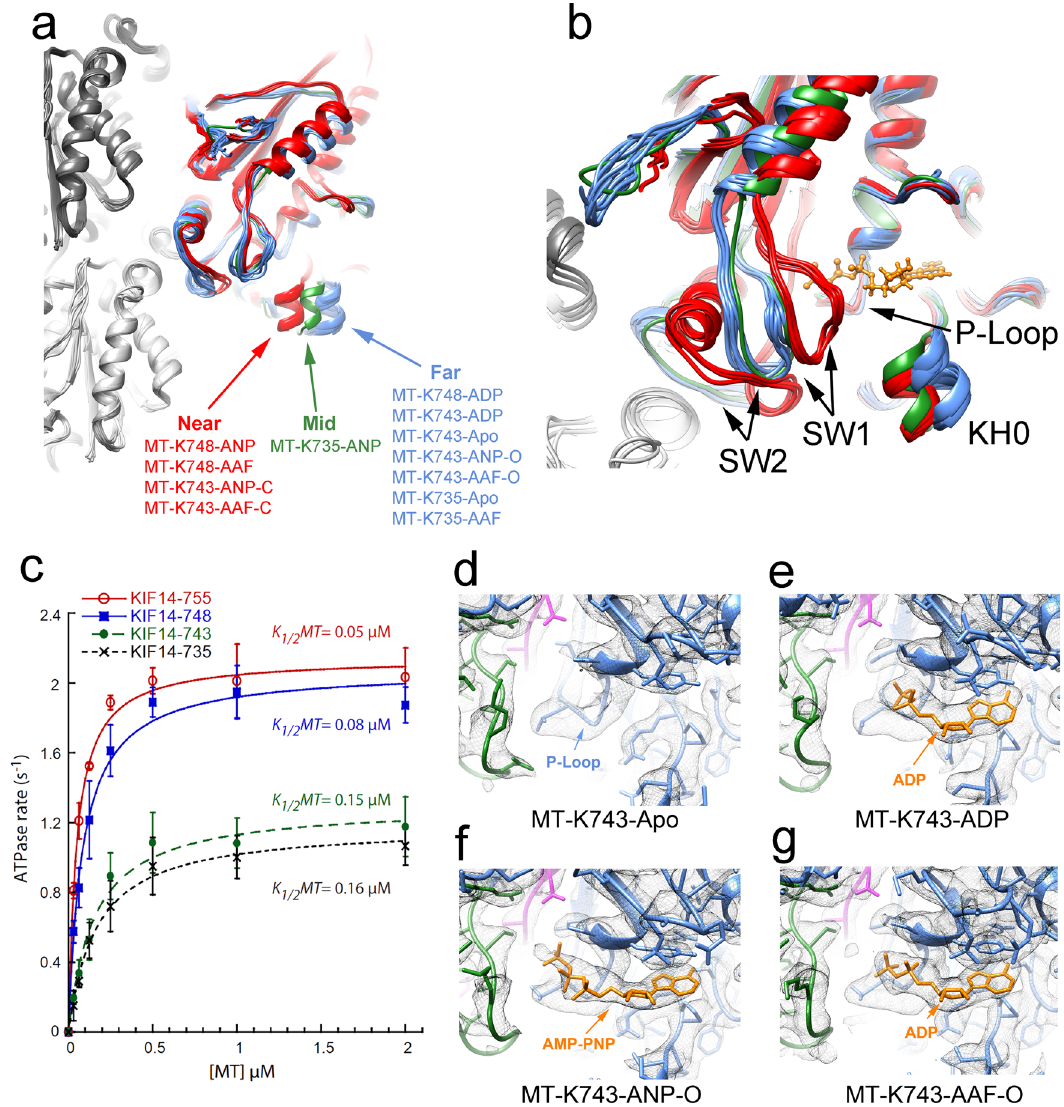
Fig. 5 Neck-linker control of nucleotide-binding pocket closure. a MT-KIF14 atomic models aligned to their corresponding β -tubulin chains. Three distinct locations of KH0, are observed: near, corresponding to the closed con fi guration (red); mid and far corresponding to the open/open* con fi gurations (green and blue). b Nucleotide-binding pocket view showing the same structures in ( a ) with the same colors superimposed and aligned to their corresponding P- loops. c Microtubule-stimulated ATPase rate of K735, K743, K748, and K755 constructs. The basal ATPase rate for the four constructs was 0.3 s − 1 (subtracted from the total ATPase rate values). Error bars: standard deviation ( n = 3). d – g Nucleotide-binding pocket detail of indicated structures with truncated neck-linkers all in the open con fi guration. Cryo-EM densities shown as an iso-density surface gray mesh, KIF14 model in blue with SW1 in green, SW2 in magenta, bound nucleotide (ADP or AMP-PNP) in